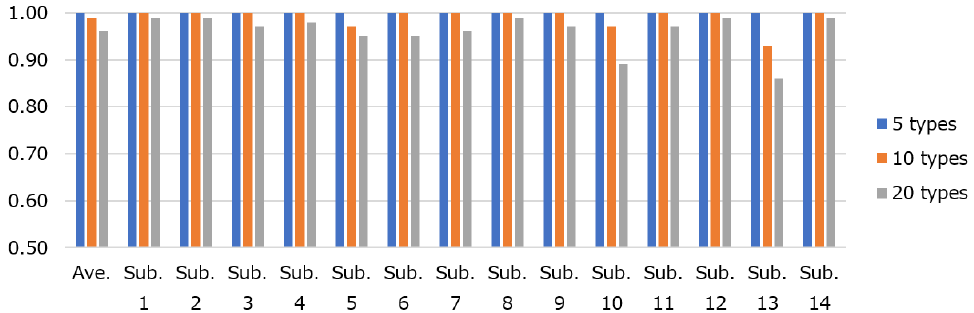
Figure 8. Results of each individual in Evaluation 1. The value is the